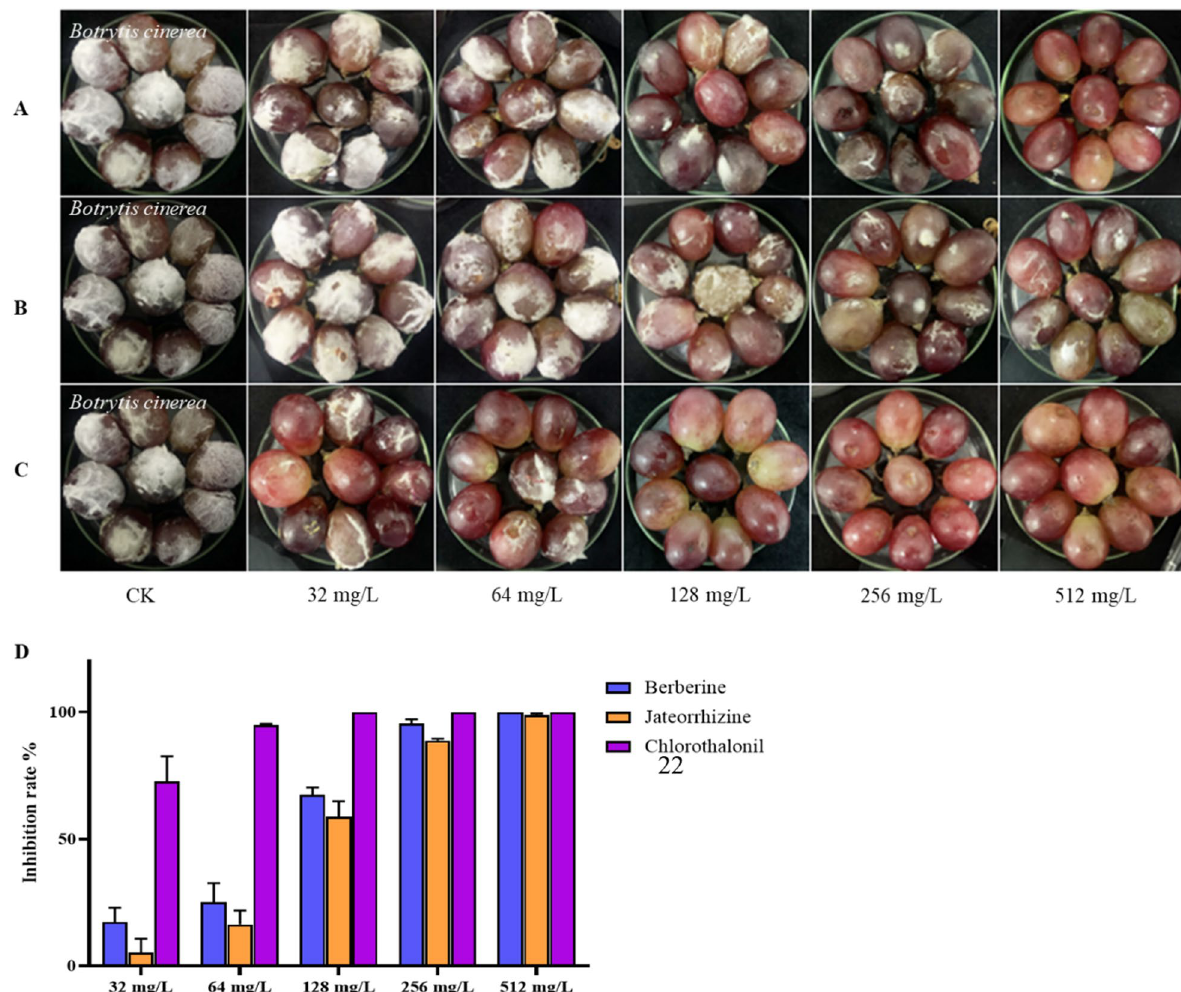
Fig. 5 Prevention of against B. cinerea of grapes with two compounds after 10 d. Treatment with ( A ) berberine; ( B ) jateorrhizine; ( C ) chlorothalonil; ( D ) inhibition rate on grape